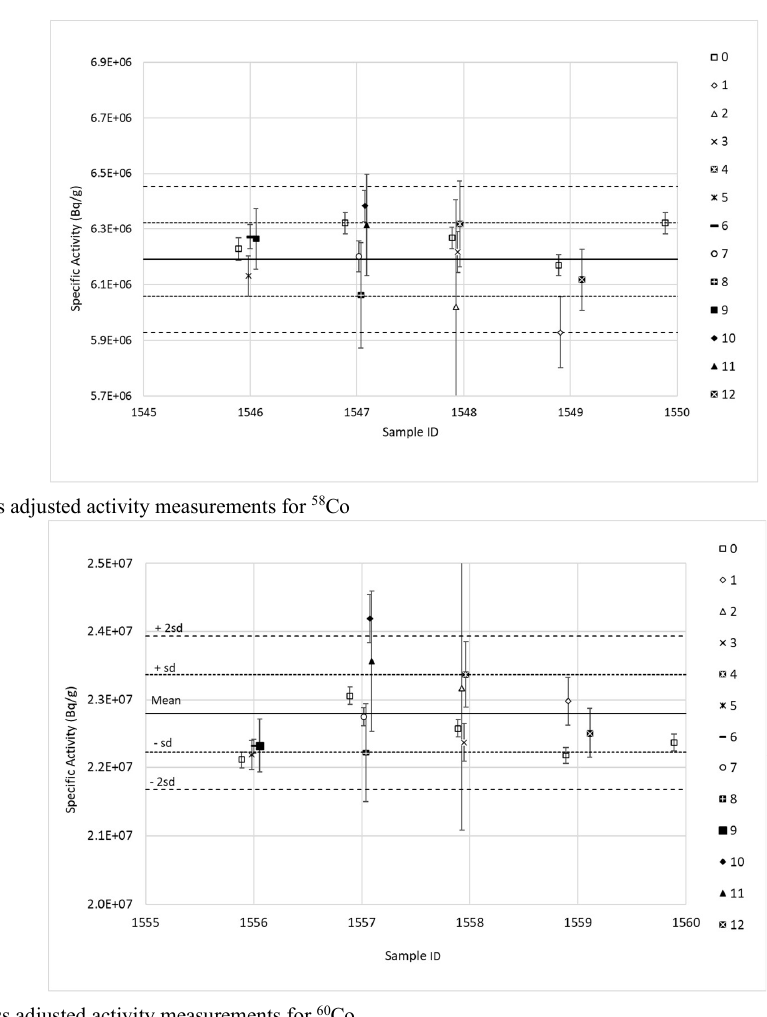
Fig. 8 Mass adjusted activity measurements for 60